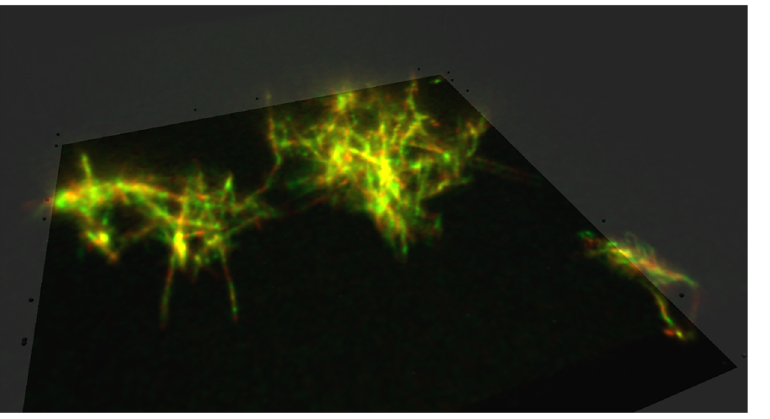
Figure 8: A view of a star-like micro- tubule rendered in our VR confocal image viewer mode, courtesy of Dr. Yutaka Ueno (AIST)